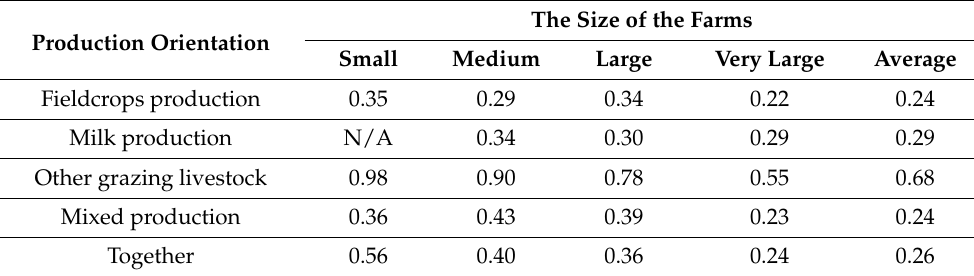
Table 13. Agricultural subsidies to agriculture production (2015–2020 average). Production